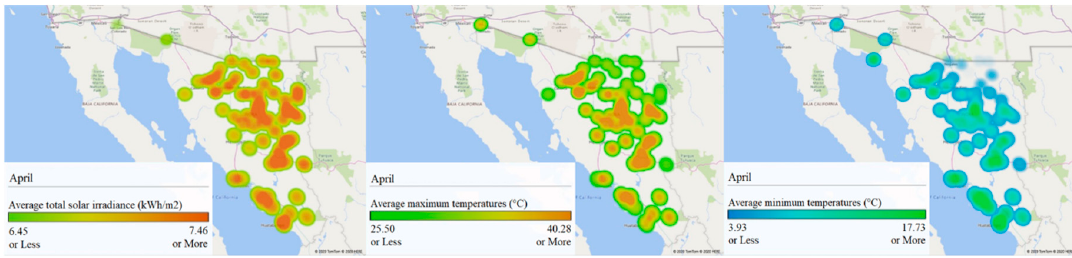
Figure 9. GIS analysis of Sonora for March: ( left ) average total solar irradiance (kWh/m 2 ), ( center ) maximum average temperatures (°C), and ( right ) minimum average temperatures (°C).